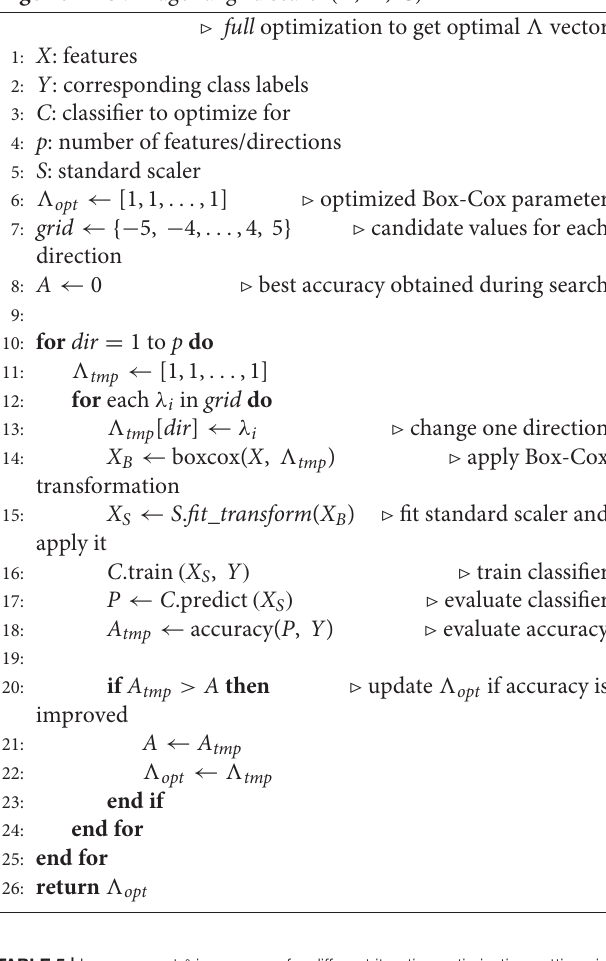
TABLE 5 | Improvement δ in accuracy for different iterative optimization settings in the sonar